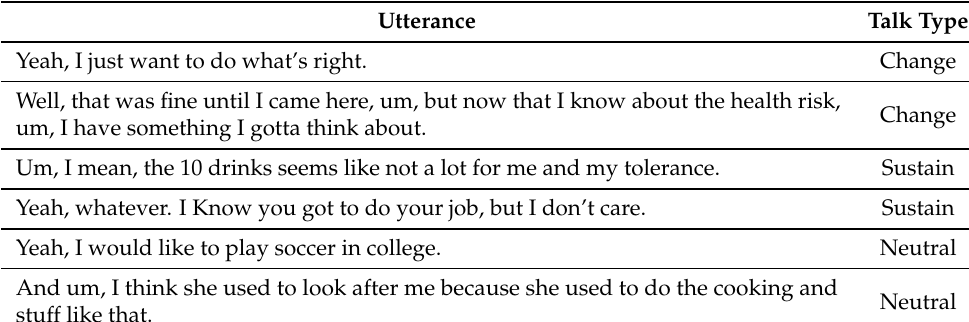
Table 8. Example labelling for client Talk Type from the dataset. Utterance Talk Type